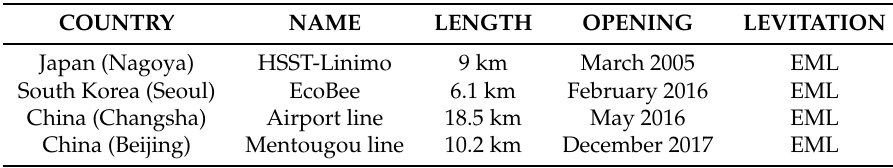
Table 2. Urban MagLev Projects in commercial use.